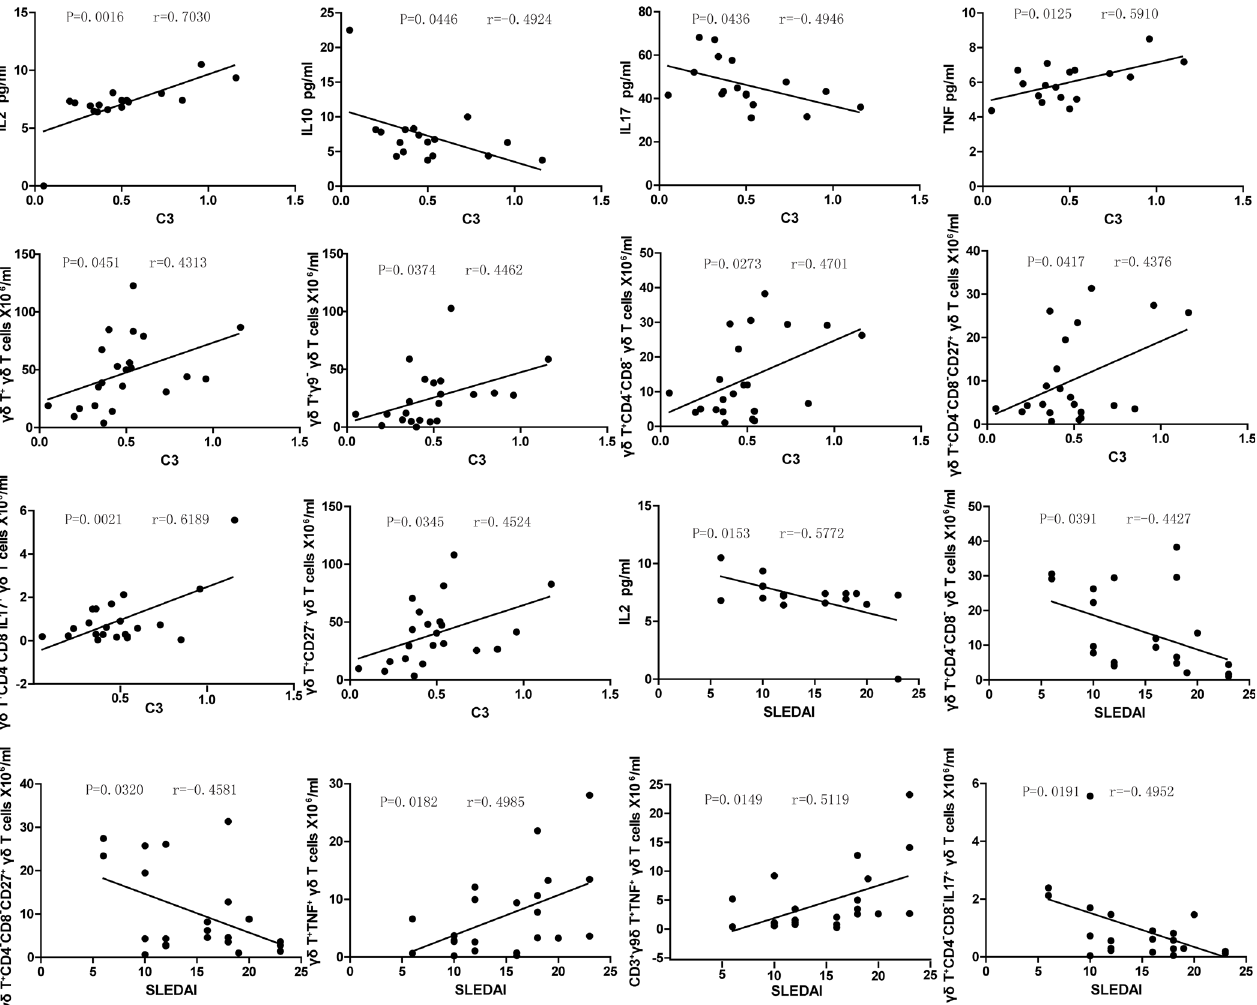
Fig 5. Correlations between γδ T cell subsets size and the clinical indicators. The levels of the serum C3 and SLEDAI scores were correlated to various serum cytokines and to pan γδ T cell numbers and to γδ T cell subsets in SLE patients. There is no significant correlation among other parameters tested (data not shown), see text for